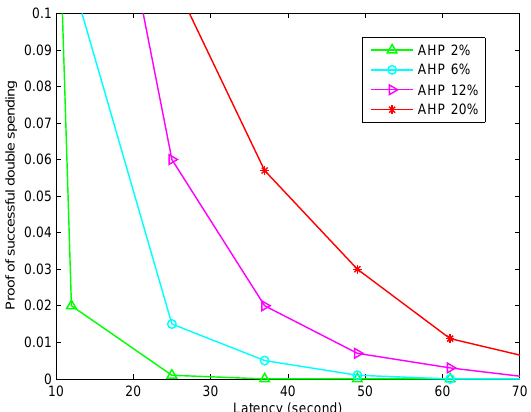
Figure 7. The security against different latencies. Here, we take the impacts from different attacker hash powers (AHP) into